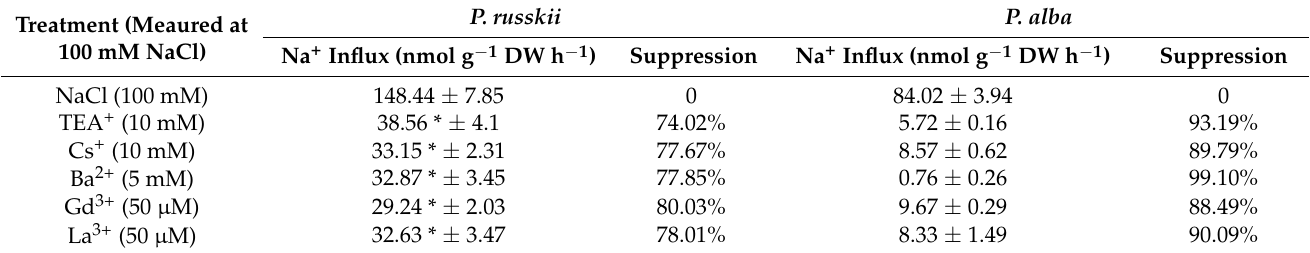
Table 1. Effects of pharmacological treatments on low-affinity Na + influx in Populus plants under 100 mM NaCl. Na + concentrations were measured before treatments and after NaCl and inhibitor treatments for 24 h (each treatment had three biological replicates). Measurements significantly different from the control are indicated with a *, p < 0.05 ( t -test). Values represent mean ± SD (n = 3).